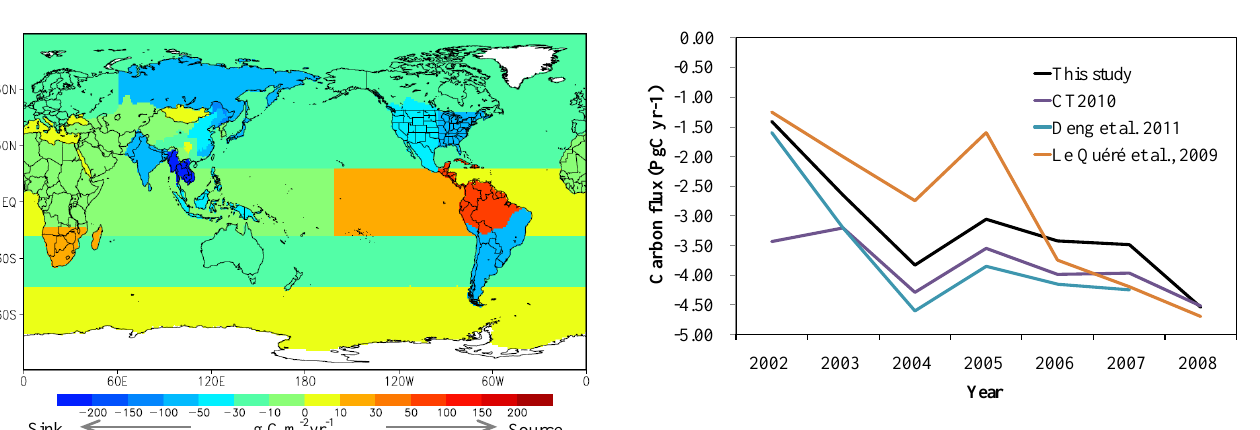
Fig. 3. Inverted mean distribution of terrestrial and ocean carbon fluxes (averaged for 832